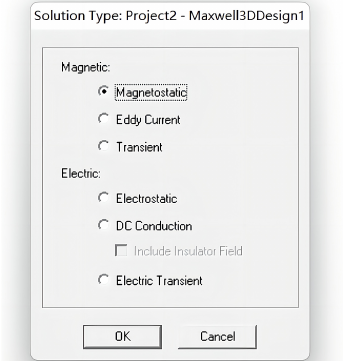
Figure 6. Solution type selection diagram.